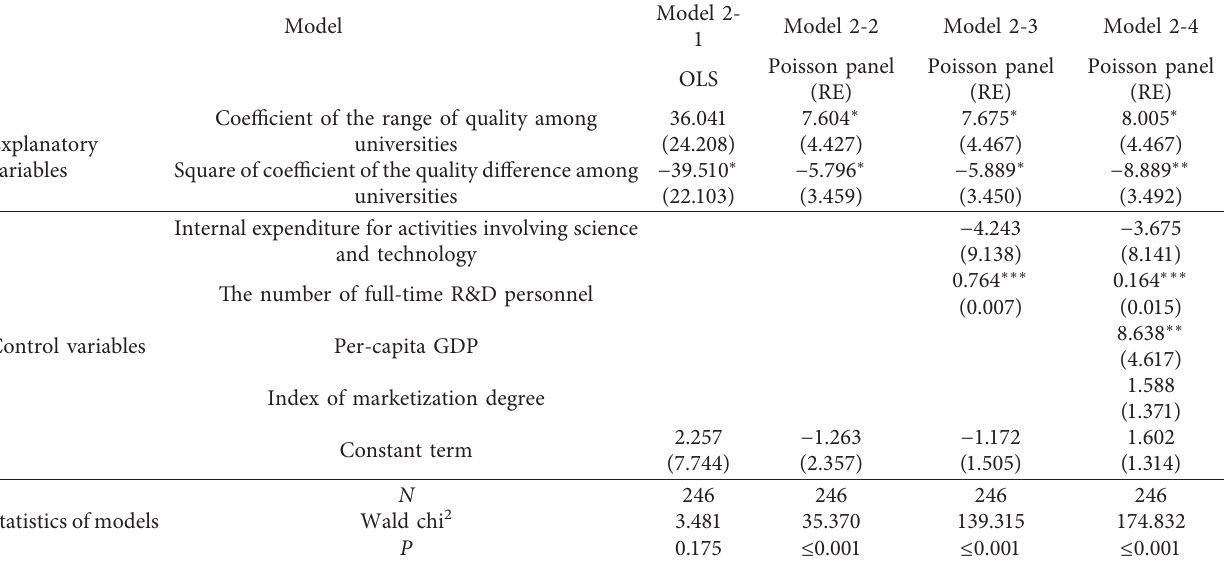
Table 4: Preliminary empirical results of the macro data